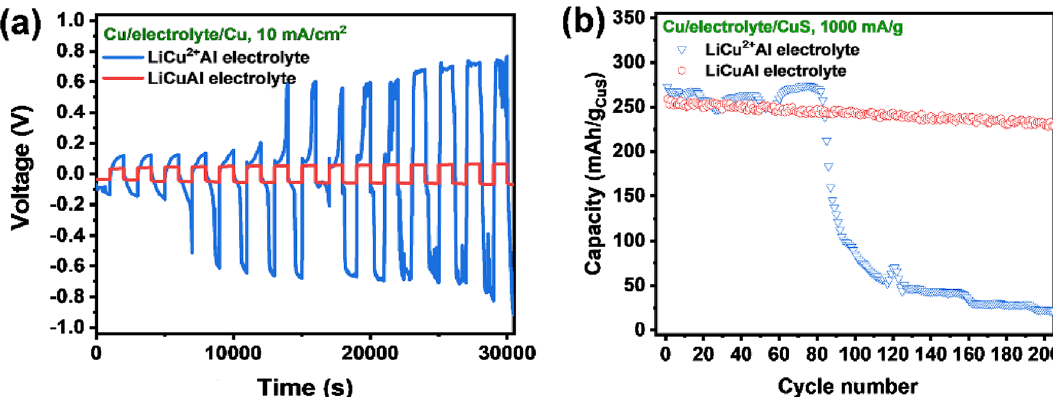
Figure 4. Electrochemical performance of copper anode and Cu–Al dual-ion battery in different valence copper salts: ( a ) cyclic charge–discharge tests of copper anodes. ( b ) Cycling stability of Cu–Al dual-ion